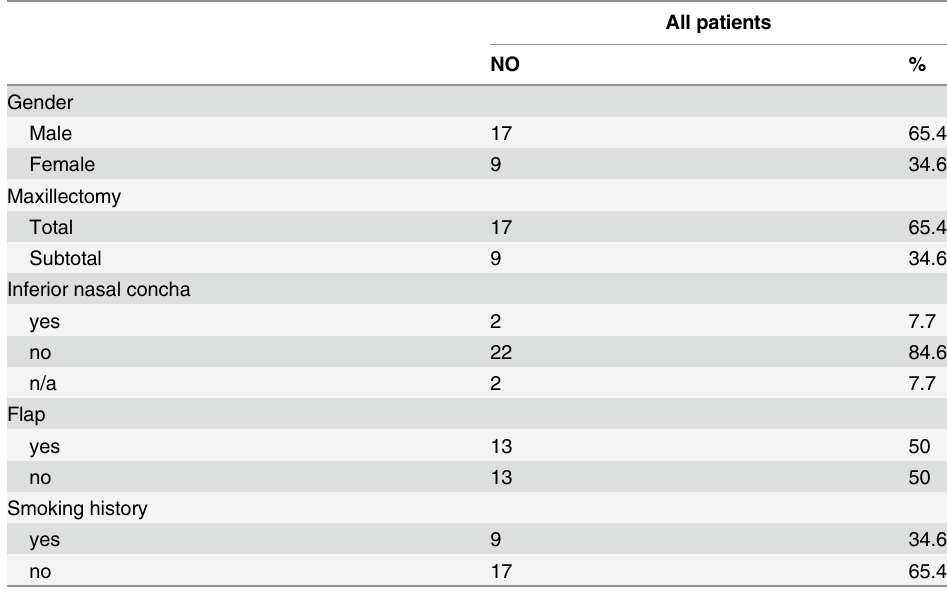
Table 1. Patient Information.